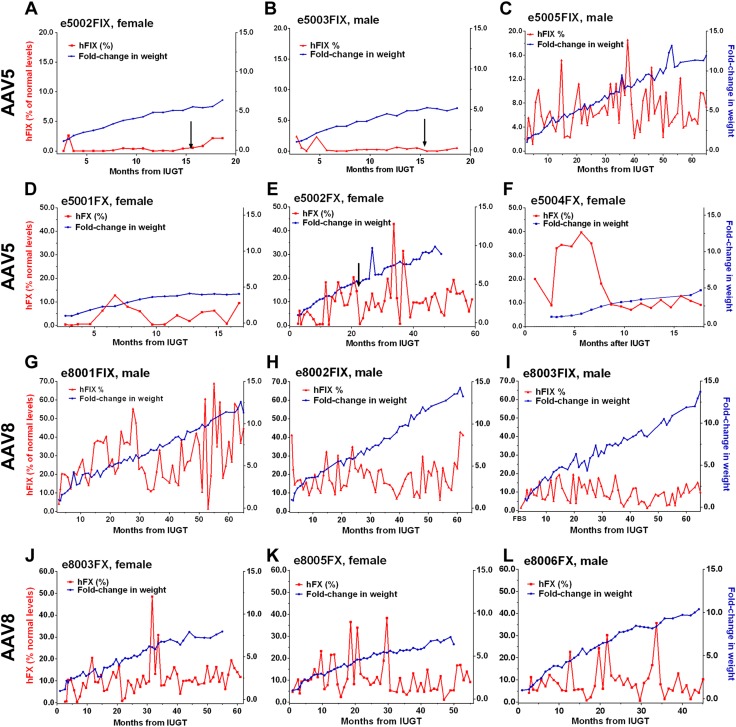
Individual hFIX and hFX expression in treated animals. A–C) Animals treated with AAV5-hFIX and monitored beyond infancy were e5002FIX (A) and e5003FIX (B), both of which showed subtherapeutic levels, and e5005FIX (C), which demonstrated therapeutic levels. (D–F) expression in e5001FX (D), e5002FX (E), and e5004FX (F) fluctuated between subtherapeutic (<1%) and high levels, whereas infant body mass steadily increased; e5004FX showed the more stable expression overall. G–I) AAV8 recipients were e8001FIX (G), e8002FIX (H), and e8003FIX (I), which sustained hFIX expression >1% (100% = 5 µg/ml) despite rapid growth. J–L) e8003FX (J), e8005FX (K), and e8006FX (L) fared similarly with median hFX expression in the therapeutic range (100% = 10 µg/ml). Arrows: postnatal VC.